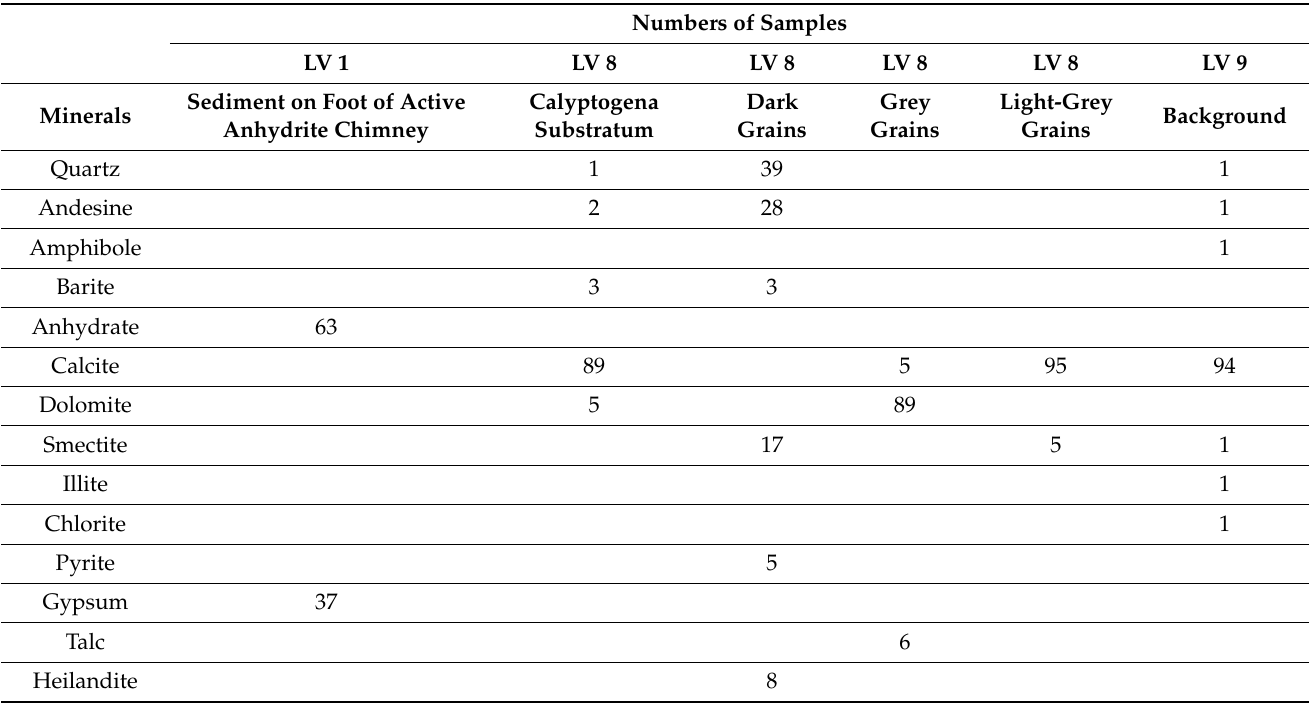
Table 3. Mineral composition of sediment specimens from the active southern top of the Piip Volcano and from the background